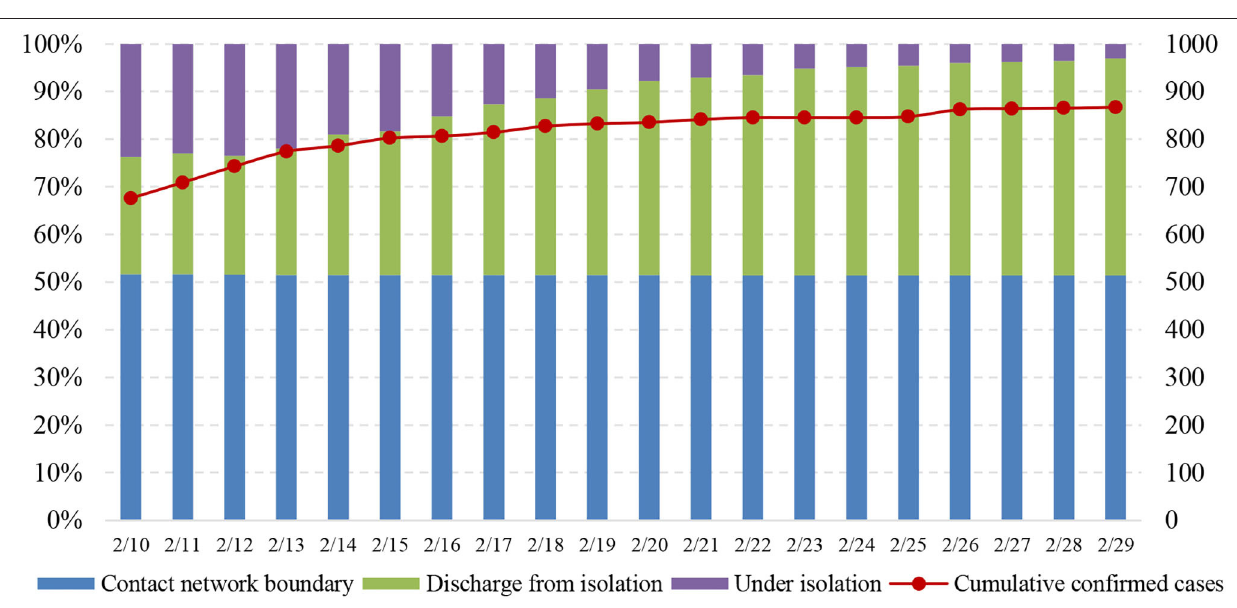
FIGURE 9 | Total number of close contacts by confirmed